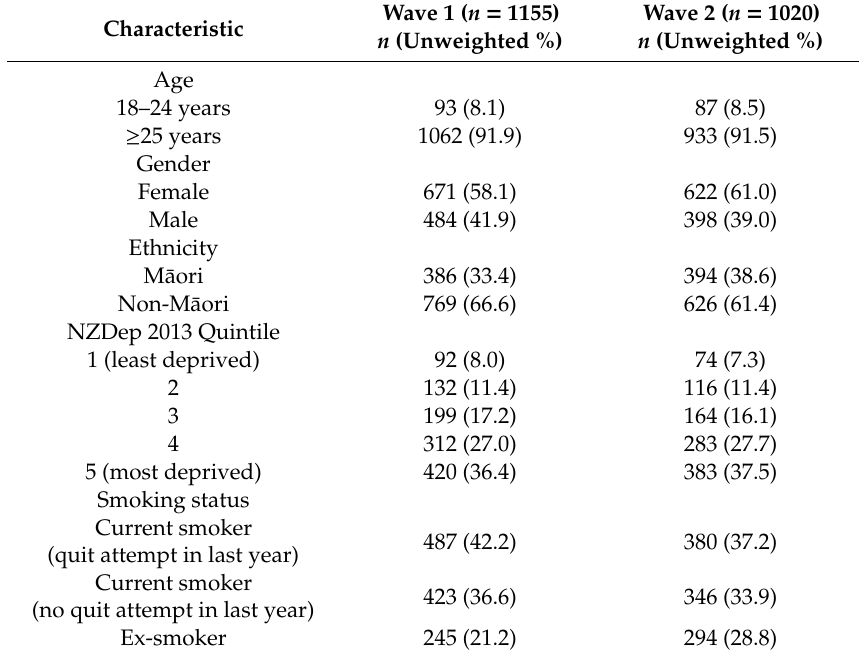
Table 1. Sample characteristics in Waves 1 and 2 of the International Tobacco Control (ITC) New Zealand Survey.